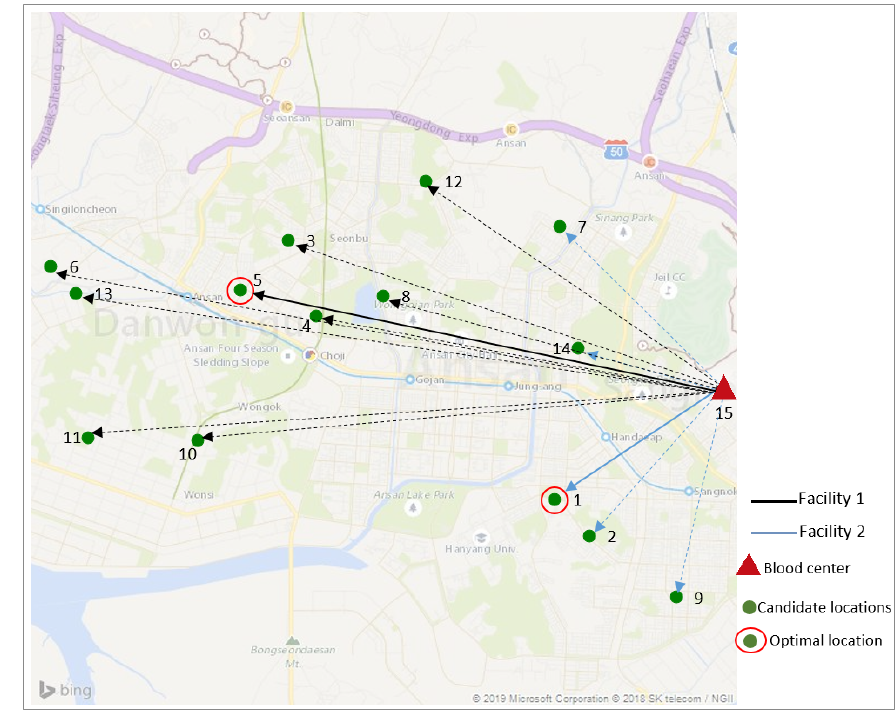
Figure 4. Optimal locations of the fixed blood